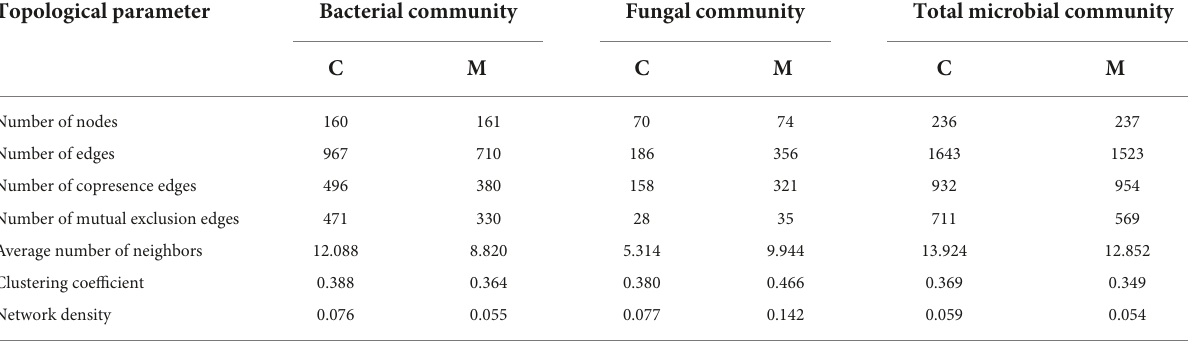
TABLE 4 Topological parameters of soil microbial ecological networks under different organic manure treatments. Topological parameter Bacterial community Fungal community Total microbial